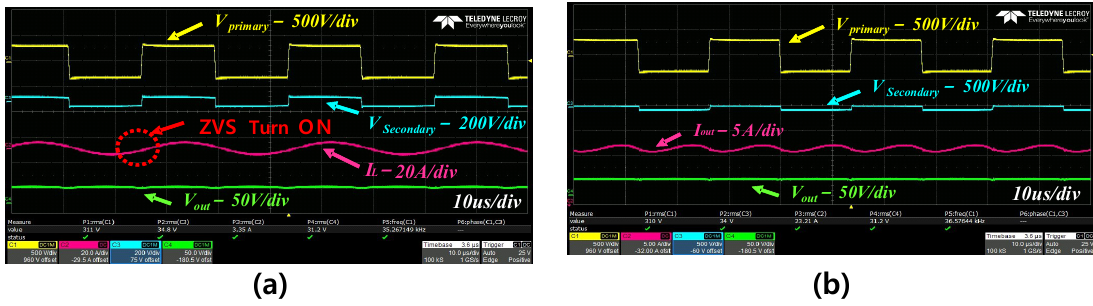
Figure 12. LIB CC (Constant Current) mode charging waveform; ( a ) Vprimary, Vsecondary, IL, Vout; ( b ) Vprimary, Vsecondary, Iout, Vout.